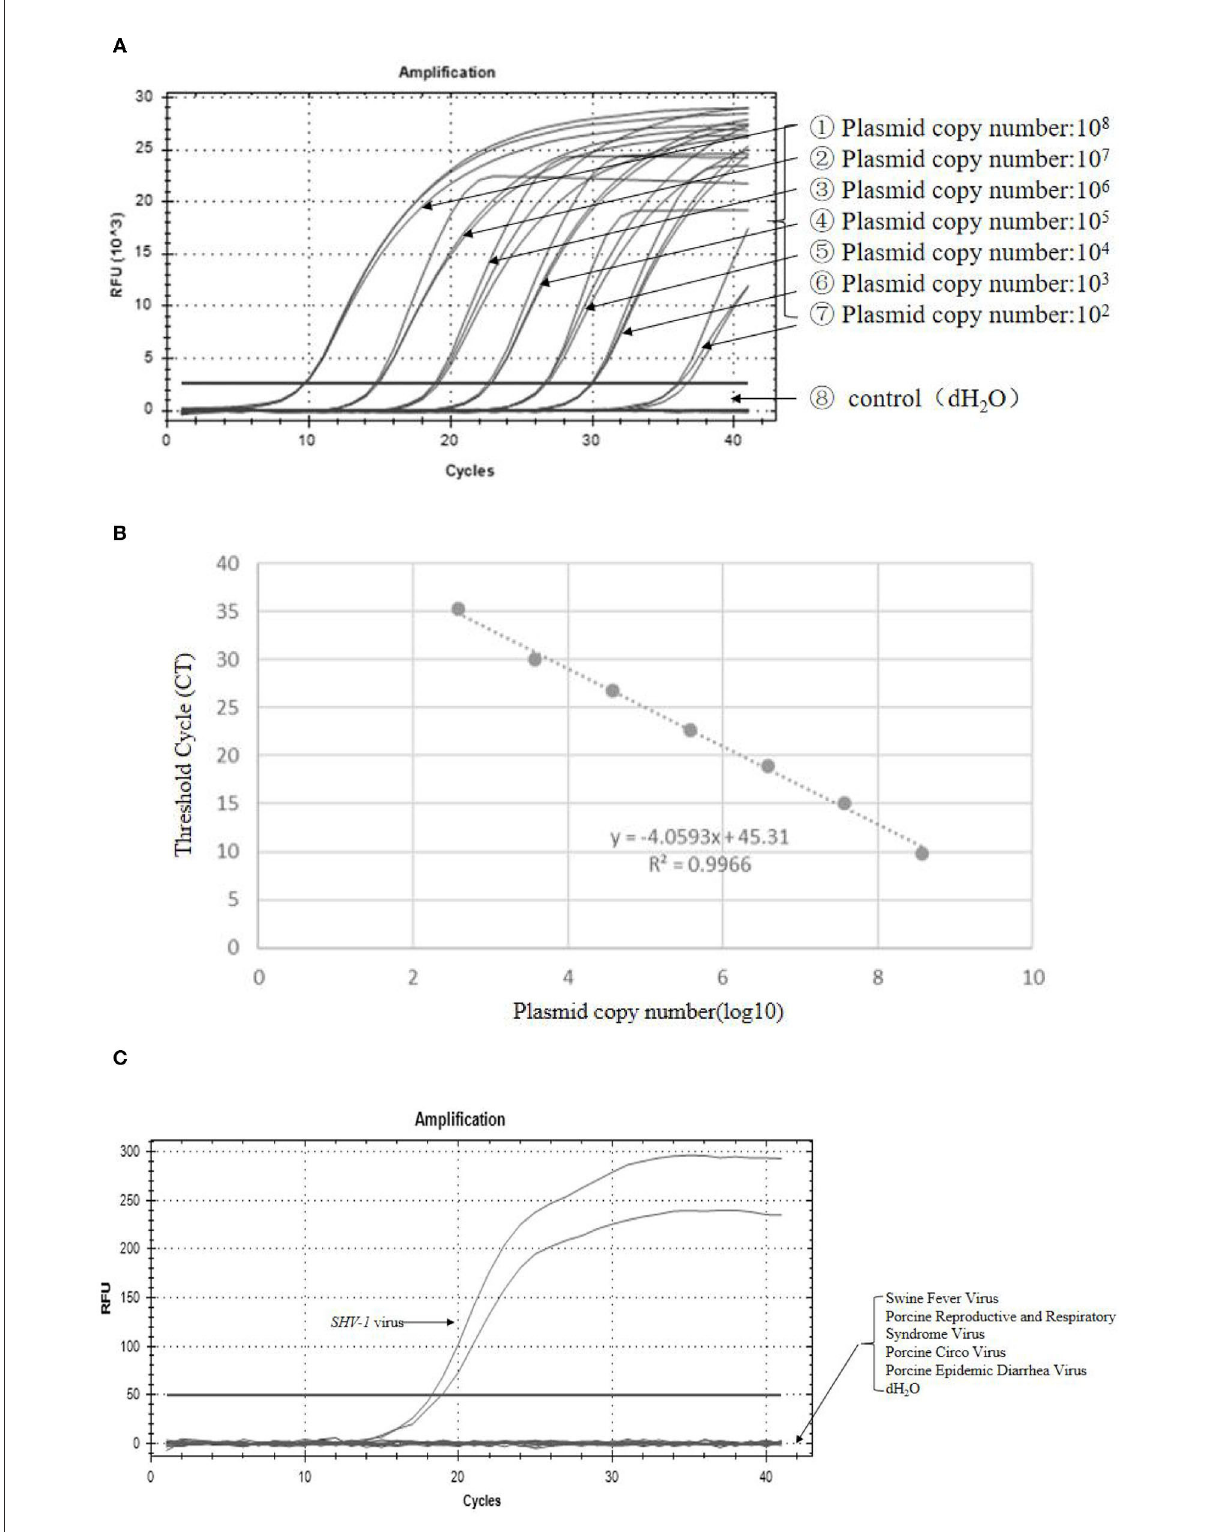
FIGURE5 Primer 1 showed high specificity and sensitivity for detection of SHV-1. (A) The amplification curve was established with the recombinant plasmid pUC19-SHV-1-gE standard; (B) standard curve line, where y represents the Ct value and x represents the logarithm of the gene copy number concentration; R 2 = 0.9966; (C) fluorescence quantification of different viruses. The control group was swine fever virus, porcine reproductive and respiratory syndrome virus, porcine circovirus, porcine epidemic diarrhea virus, and dH 2